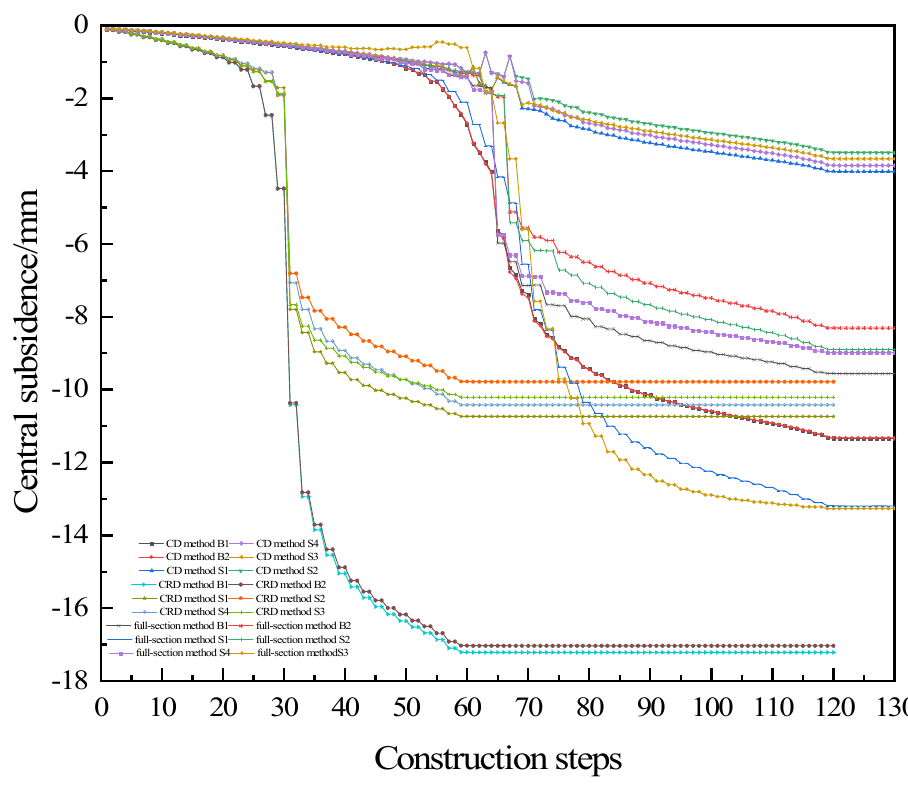
Figure 9. Settlement diagram of the secondary lining arch.